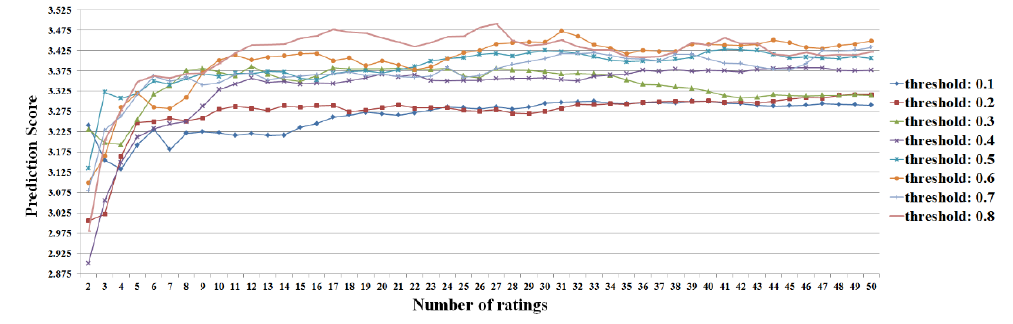
Figure 9. Results of the prediction scores based on the Pearson correlation coefficient in the item-based filtering.